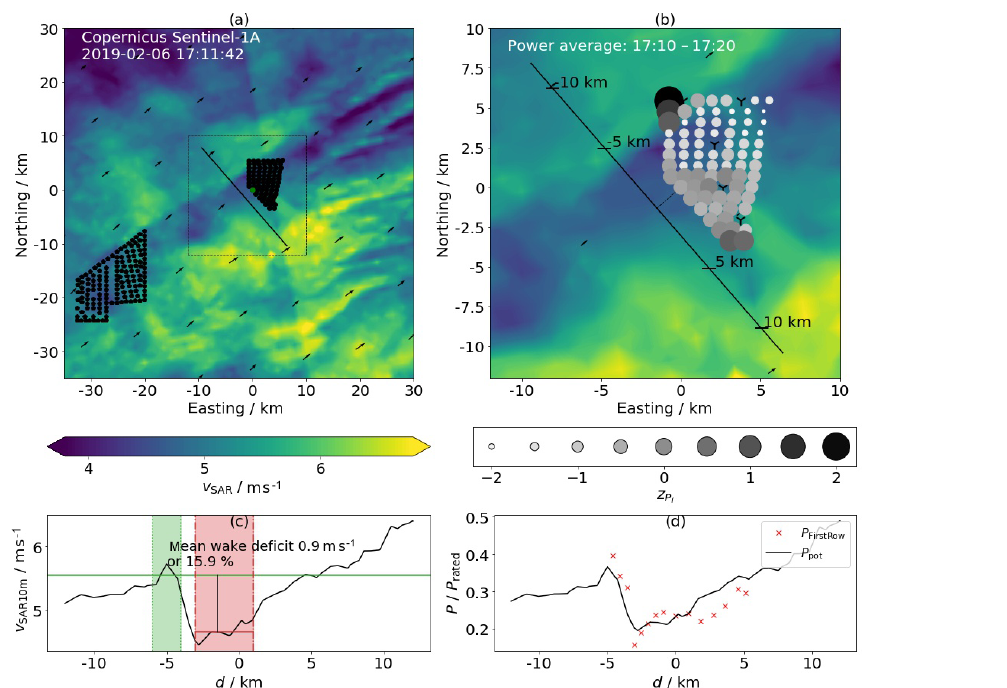
Figure 5. Sentinel-1A Ocean Wind Field (Copernicus Sentinel data (2019)), measurement taken 6 February 2019 17:11:42UTC. (a) Overview of the BorWin cluster and Global Tech I. (b) Close look on the BorWin wake hitting GT I. The solid line marks a virtual wake cut 2000m upstream of turbine GT58 on which the wind field is evaluated. Marked distances correspond to the x axis of (c) and (d) . The z score of the turbine power z P (see Eq. 1) is shown in greyscale for the relevant 10min period (17:10–17:20UTC); markers scale i with z − z min . Numbers of upstream turbines to calculate the z score are 1, 9, 16, 23, 30, 37, 44, 51, 58, 64, 69, 73, 76, 79, and 80. Turbines not operating the full period or operating at curtailed power are excluded and marked ( Y -shaped marker). (c) Wind speeds along the wake cut from (b) . Wake and the free stream are shaded (regions selected manually). (d) Potential power on hub height along the wake cut (solid line) together with the power produced by the upstream turbines in GT I within the regarded 10min interval with turbine positions projected to the wake cut. A constant value of 1.0ms − 1 was added to v SAR , 10m for the